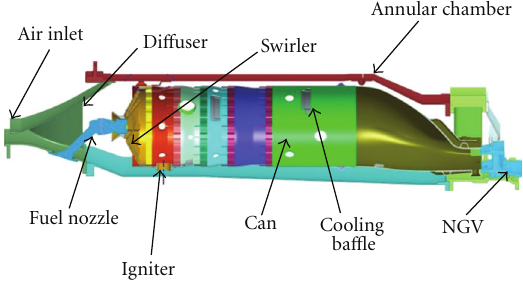
Figure 1: A 60-degree sector.